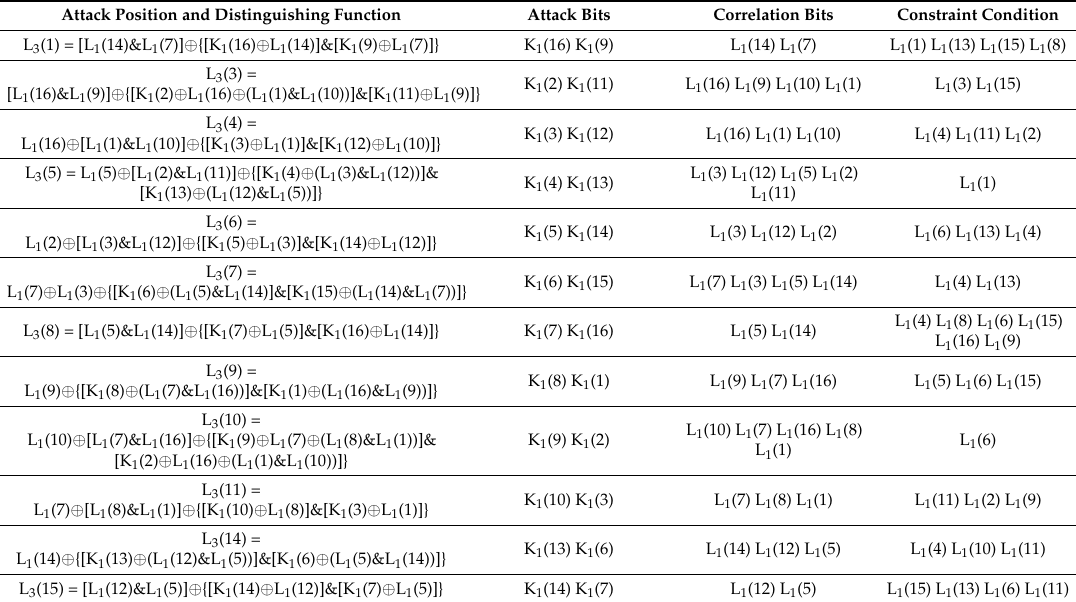
Table 1. The discriminant function of first round